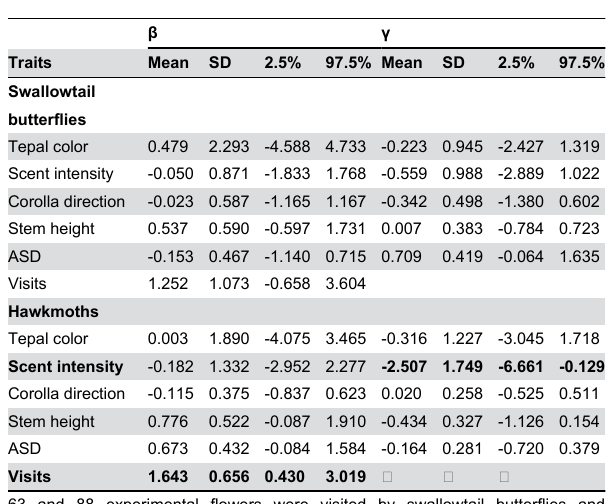
Table 4. Means and 95% confidence intervals of the posterior distribution of linear (β) and quadratic (γ) parameters in analyses of pollen